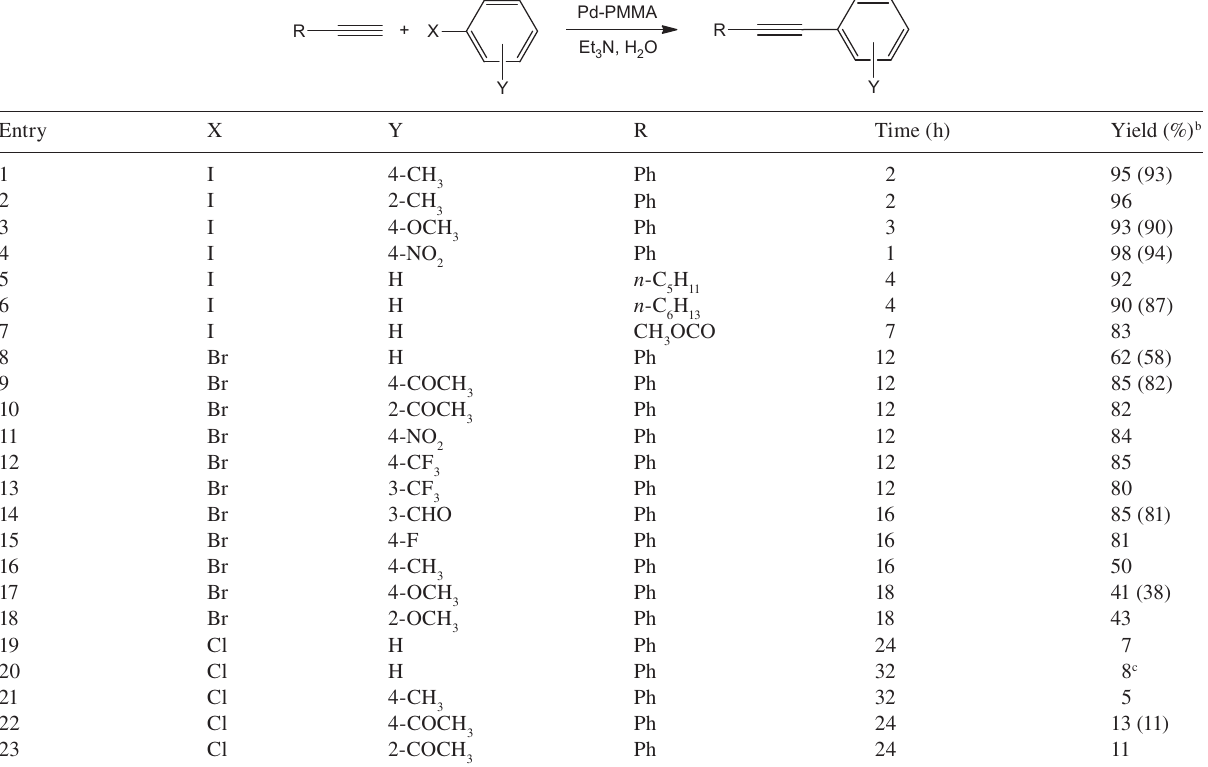
Table 3 The Sonogashira reactions in the presence of Pd-PMMA in water. a R + X